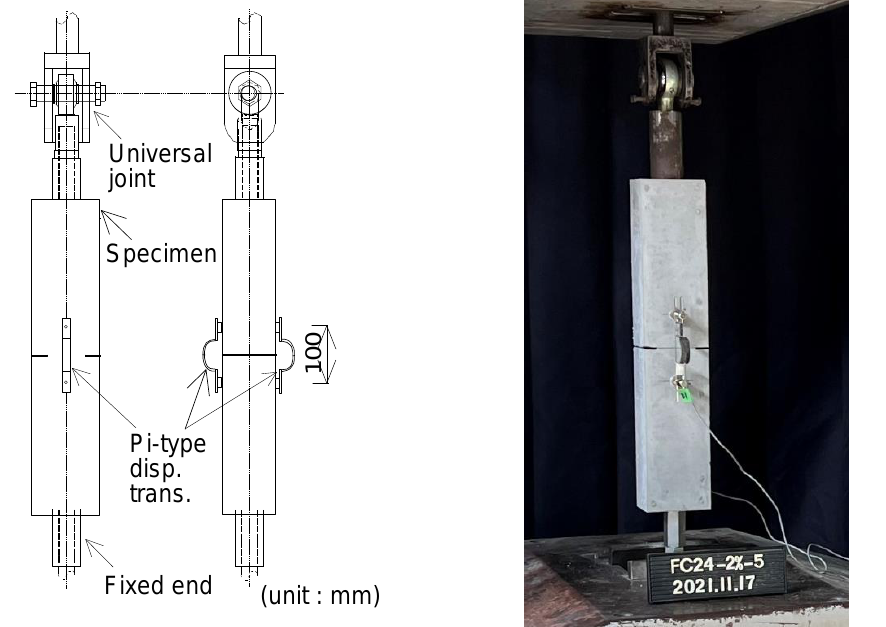
Figure 3. Setup of loading and measurement for uniaxial tension test.